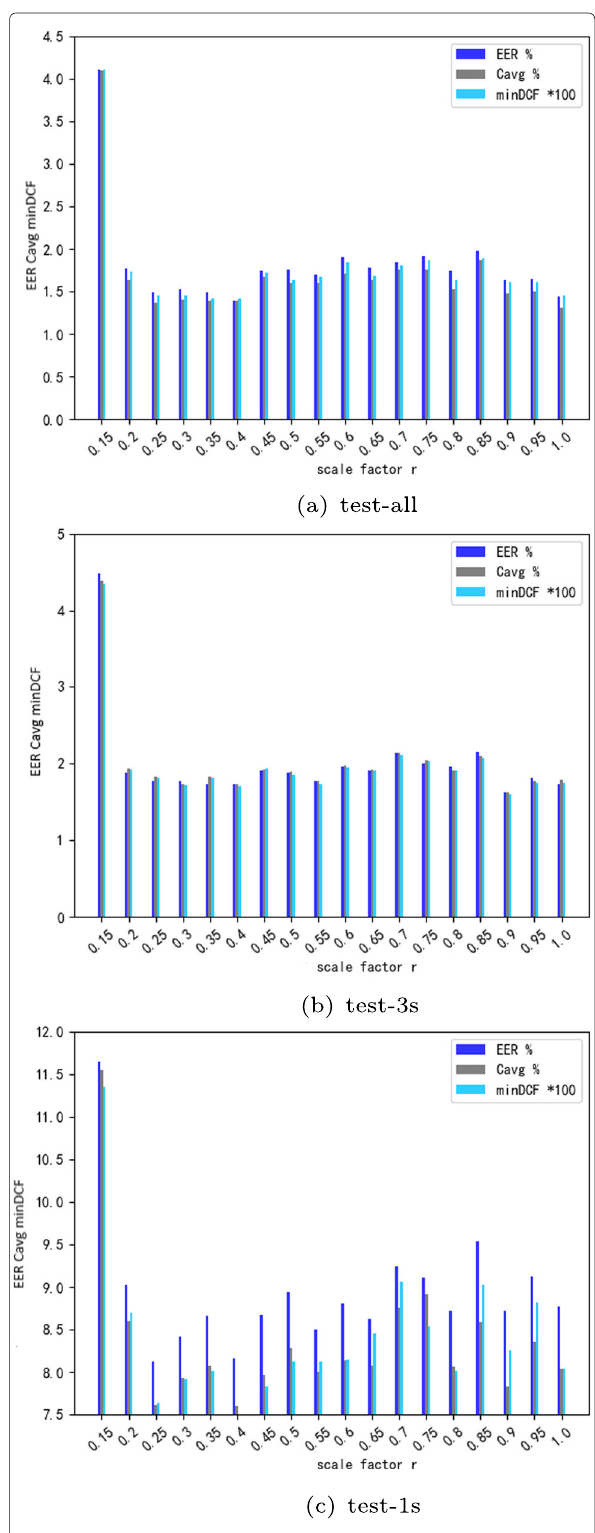
Fig. 4 Experimental results with different scale factors ( r ). The number of centers K is fixed at 3, and the margin m is set at